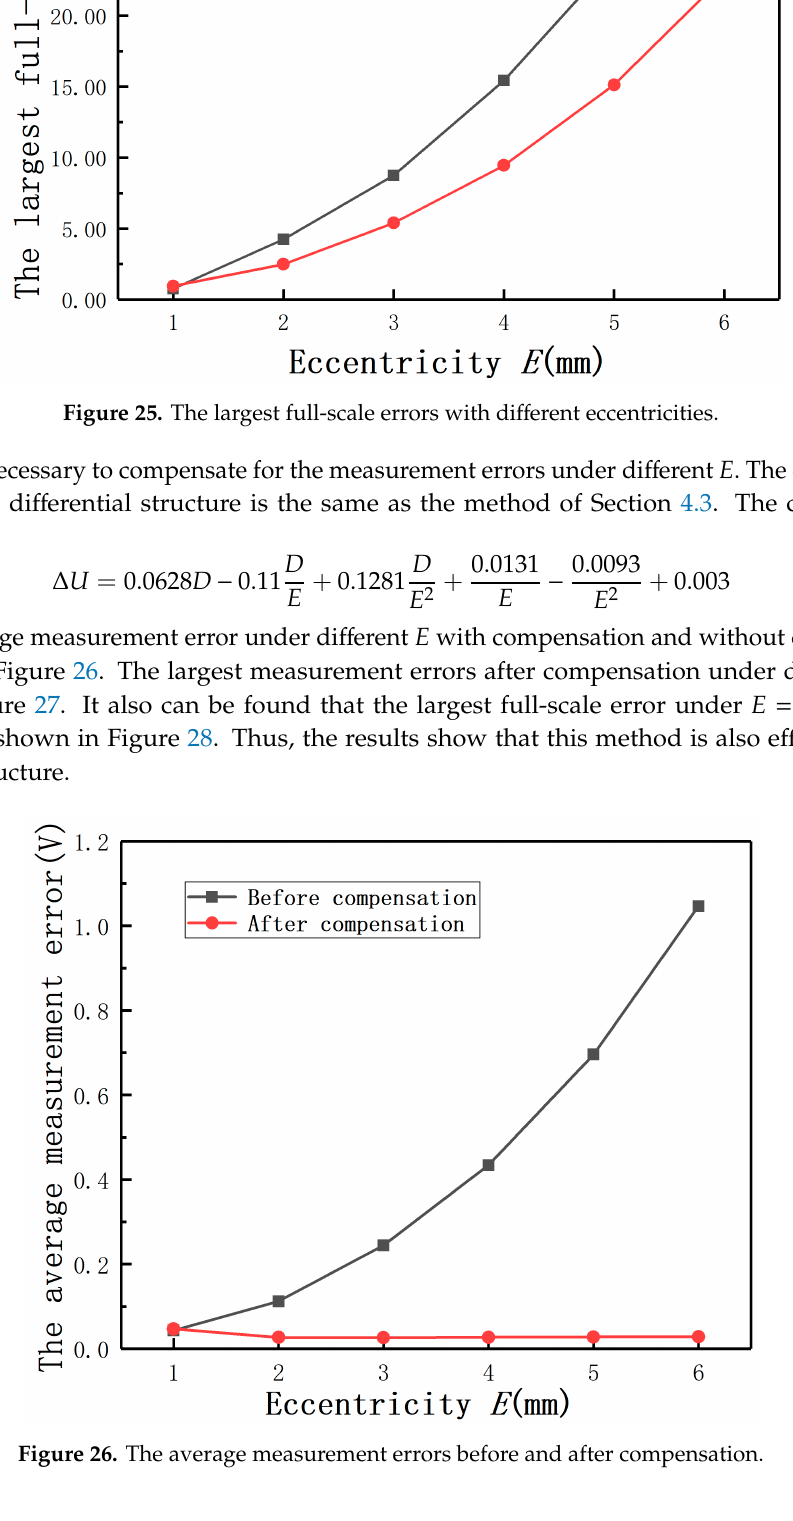
Figure 27. The largest measurement errors and the average measurement errors after compensation.